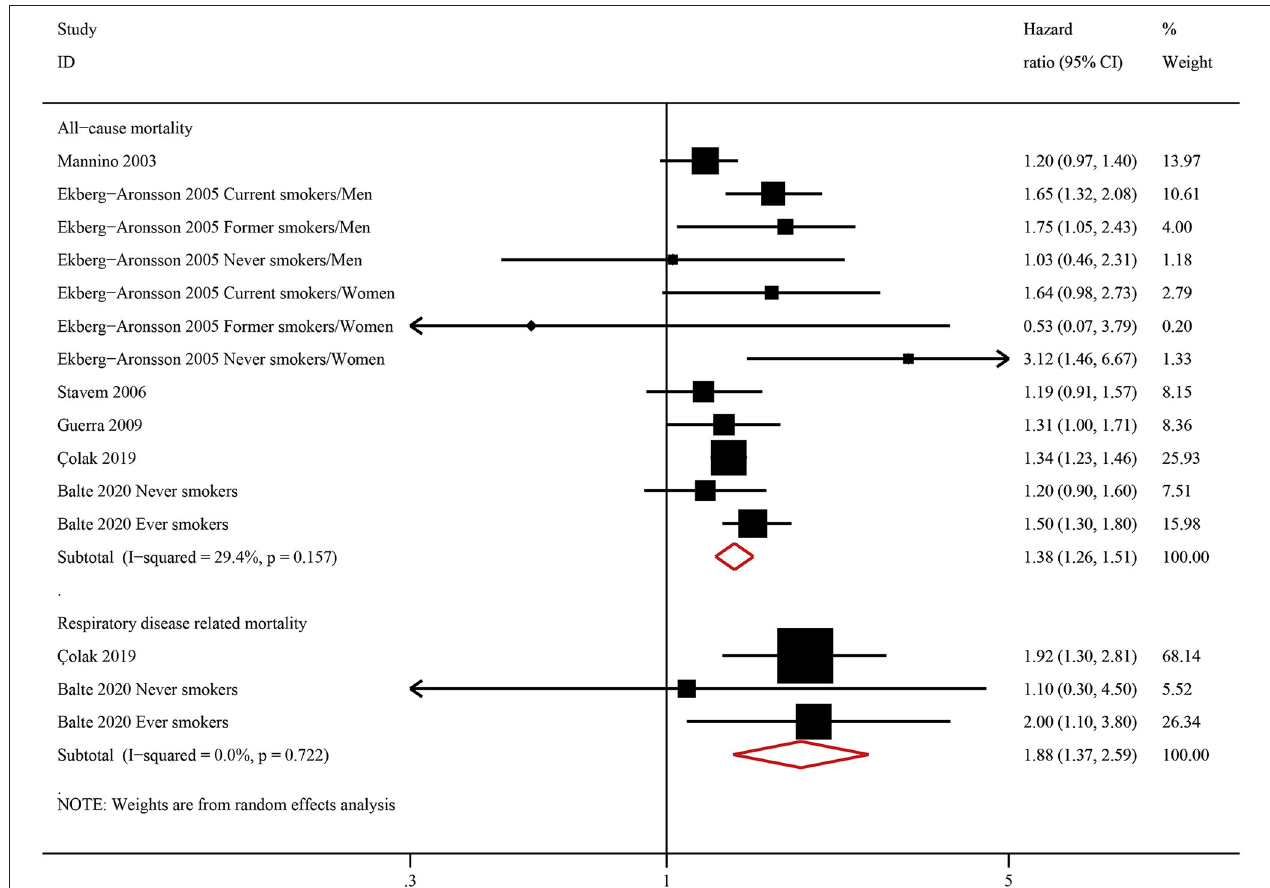
FIGURE 3 | Forest plot of the risk of all-cause mortality and respiratory-related mortality in individuals with non-obstructive chronic bronchitis compared with individuals without non-obstructive chronic bronchitis. Without non-obstructive chronic bronchitis was defined as normal spirometry and no chronic bronchitis.